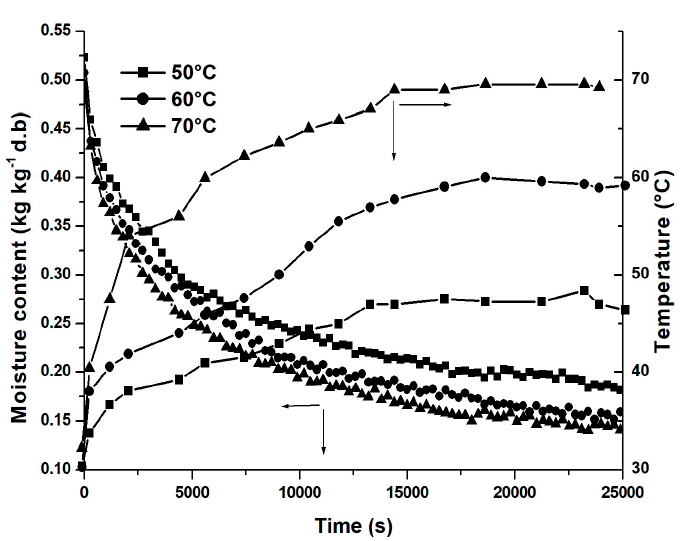
Figure 6. The effect of the air temperature on the evolution of moisture content and temperature of the thin layer of corn; V = 1 m·s − 1 , (dry air: RH = 0%).